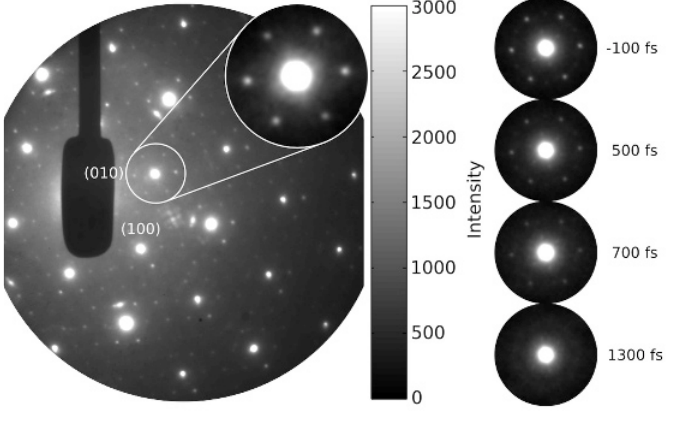
Fig. 1. Left: electron diffraction pattern of 4H B -TaSe 2 with the strong hexagonally ordered lattice Bragg reflections, and the weaker signatures of the CDW/PLD superstructure in between, again hexagonal with the √ 13 symmetry (3 a +1 b ), see also insert. Right: after photo excitation, the CDW/PLD, indicated by six weak satellite reflections, disappears on an ultrafast time scale, and recovers with time constant depending on the absorbed